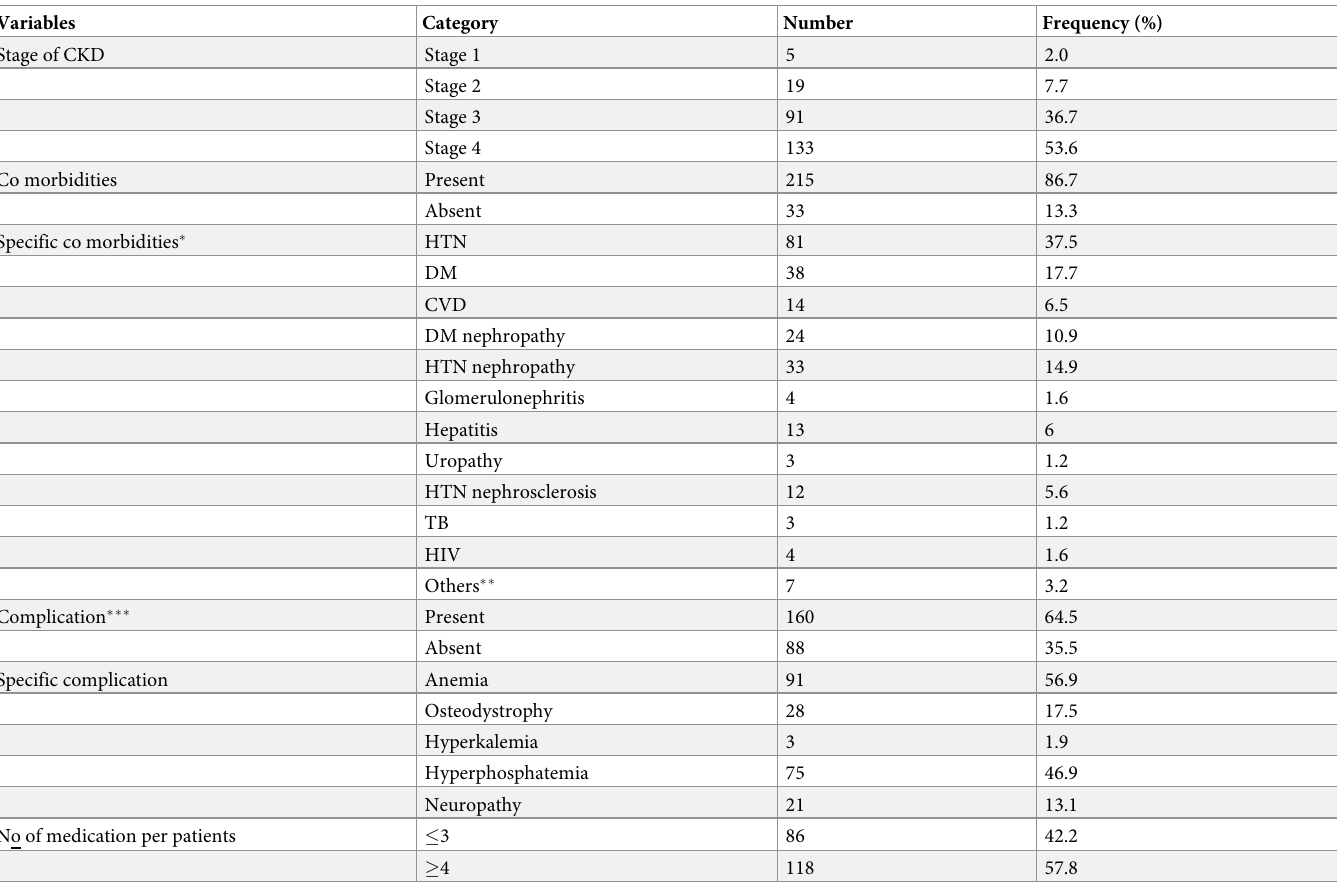
Table 2. Clinical characteristics of CKD at St. Paul’s Hospital Millennium Medical College, Addis Ababa, Ethiopia, June-August,